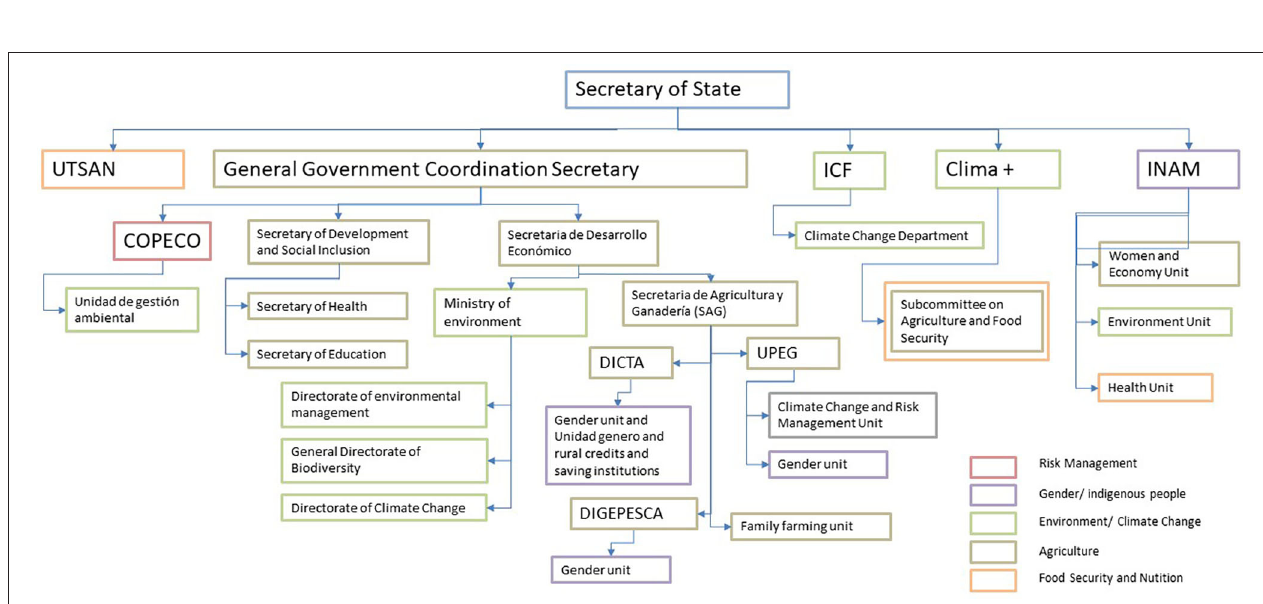
FIGURE 2 | Honduran government infrastructure on gender, agriculture, climate change, environment, risk management, and food security and nutrition (own elaboration).